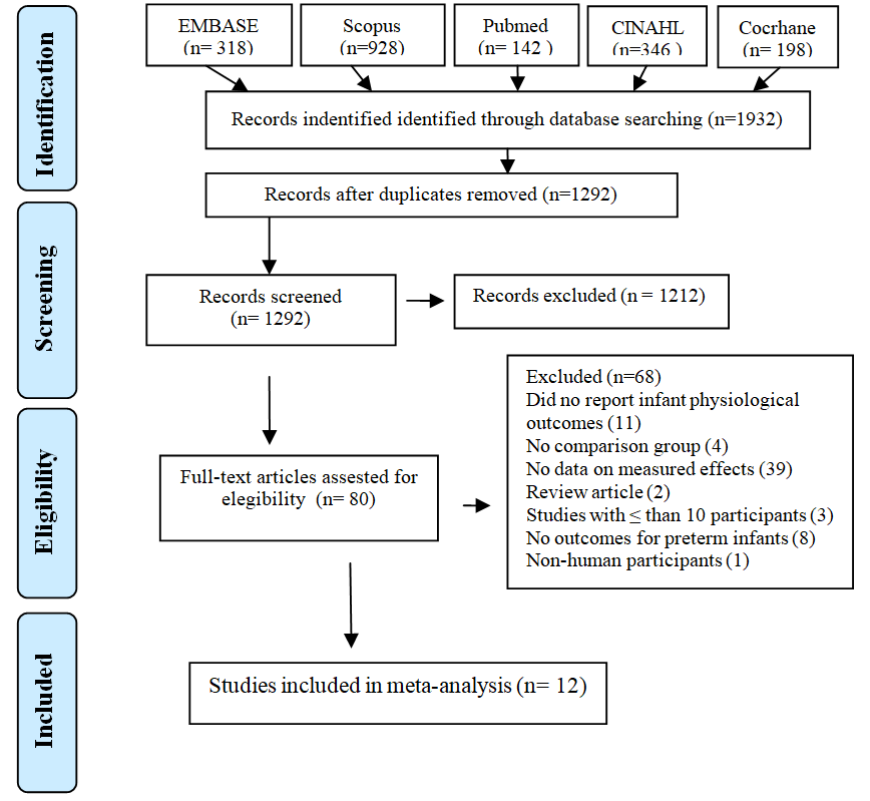
Figure 1. PRISMA flow diagram. Table 1. Characteristics of the included studies.